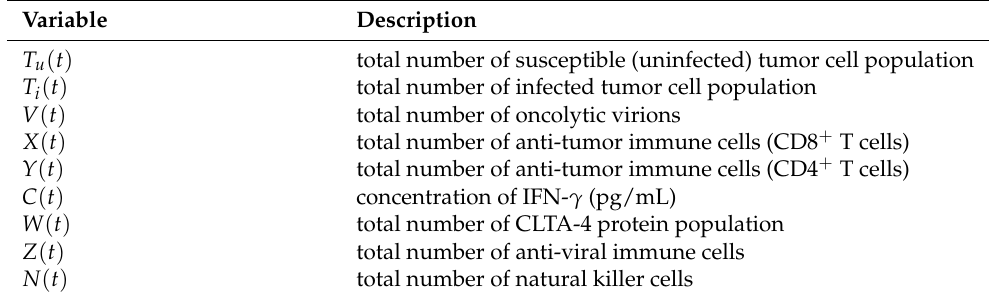
Figure 1. A schematic diagram depicts the interaction between oncolytic virus, immune cells, cytokines, and immune checkpoint with tumor cells. Uninfected tumor cells become infected by an oncolytic virus is presented. After successful viral penetration within the infected cells, infected cancer cells lyse and produce new infectious viral particles. Fragments from infected cancer cells stimulate anti-viral immune cells which subsequently kill infected cells and clear free virus. The anti-tumor immune cells (CD8 + T, NK cells, and CD4 + T cells) attack and destroy (direct/indirectly) both infected and uninfected cancer cells. T cells are also recruited by innate NK immune cells which become activated when they encounter the viruses. Cytokines activated by both susceptible and infected tumor cells, and secreted by activated T cells and NK cells, conduct the indirectly killing via activating macrophages, increasing phagocytosis of pathogen and tumor cells. Soluble proteins CTLA-4 are expressed by the activated CD4 + T cells and CD8 + T cells. It acts as a negative regulator of CD4 + T cell activation and prevents cytokine productions. NK cells are activated due to immunogenic cell death of infected tumor cells, leading to recruitment of NK cells. They are also activated in response to cytokines and vice versa. Finally, NK cells clear free viruses. Table 1. Model